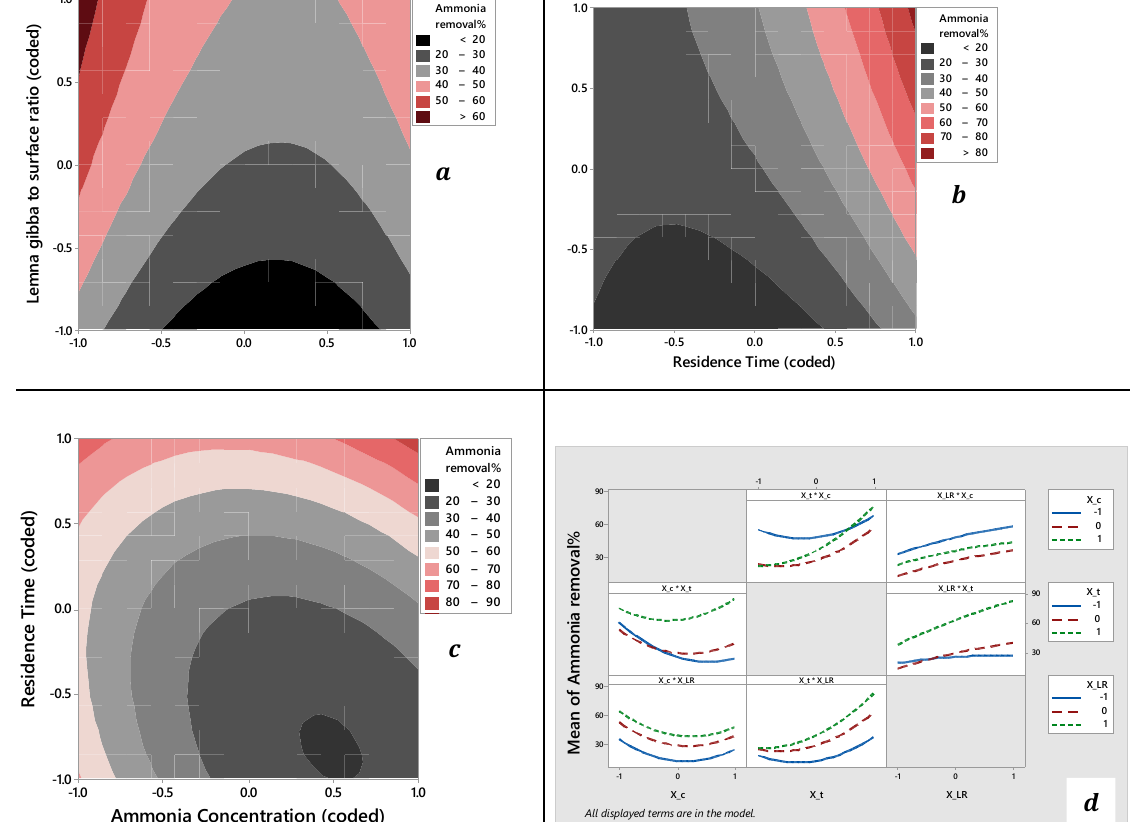
Fig. 2: (a, b, c): Contour plot of ammonia removal percents based on coded ammonia concentration, coded residence time, and Lemna gibba to surface ratio, and (d): Plot of main and interaction effects of variables on ammonia removal in (Fig. 2a: coded residence time at the intermediate maximum amount at all levels of and low level of level), the ammonia removal percent increased X (Fig. 2d). This trend declined in the intermediate t with the increase of Lemna gibba to surface ratio, level and ascended again. However, at low level while its amount and its increasing rate in lower of factor X , decrease of the ammonia removal t percent was also observed at high concentrations of concentrations of ammonia were higher. The results of the contour diagram (Fig. 2b: coded ammonia ammonia. Based on the results of interaction with concentration at the intermediate level) showed the horizontal axis X at the second column, the t that the ammonia removal percent increased with ammonia removal percent was increased at all levels the increase of residence time and its rate at higher of X and X . Considering the interaction with the LR C levels of factor X was higher. According to the horizontal axis X in the third column, the ammonia LR LR results of the contour diagram (Fig. 2b; X = 0 ), removal percent was increased at all levels of X LR LR the ammonia removal percent was negligible at the and X was increased. However, at low level of C low and intermediate levels of coded residence time factor X , change of levels in factor X did not have a t LR and at the intermediate and high levels of coded significant effect on the process of ammonia removal ammonia concentrations. According to the results from the wastewater. Model numerical optimization of interaction with the horizontal axis X in the first was performed to achieve the maximum amount C column, the ammonia removal percent reached its of ammonia removal from the wastewater. Based